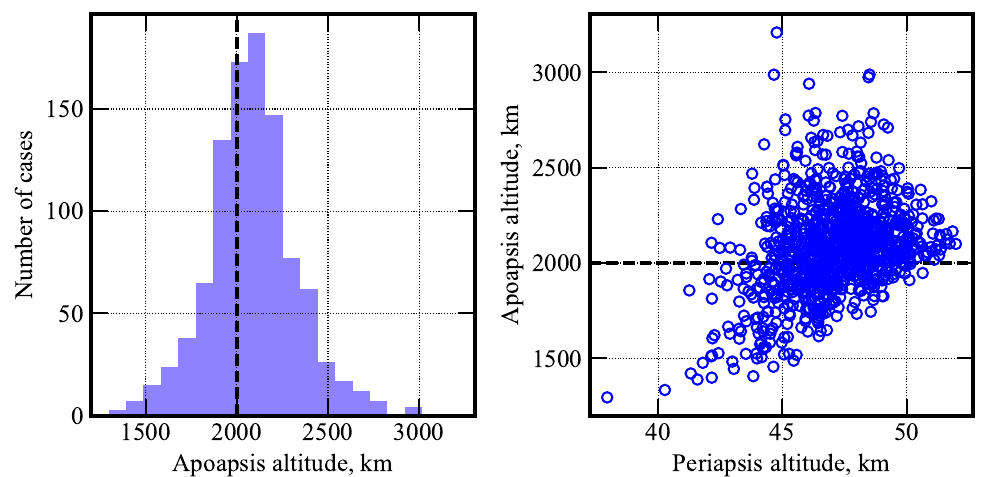
Figure 10. Histogram of the apoapsis altitude ( left ) and the apoapsis altitude and periapsis al- titude ( right ) for aerocapture at Mars. The dashed line indicates the target apoapsis altitude of 2000 km.